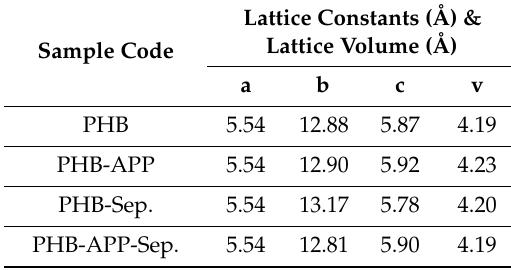
Table 7. Molecular weight of PHB and its corresponding blends.